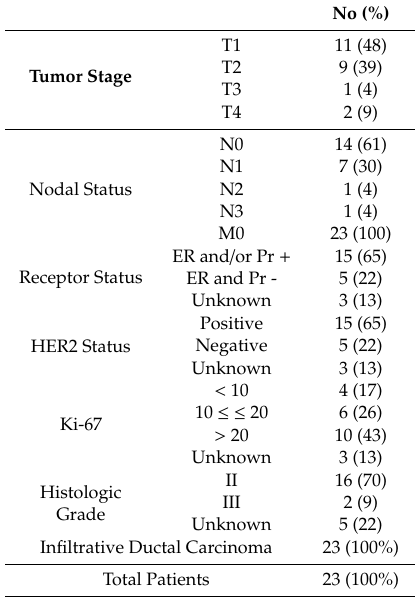
Table 1. General Clinical Characteristics of Breast Cancer